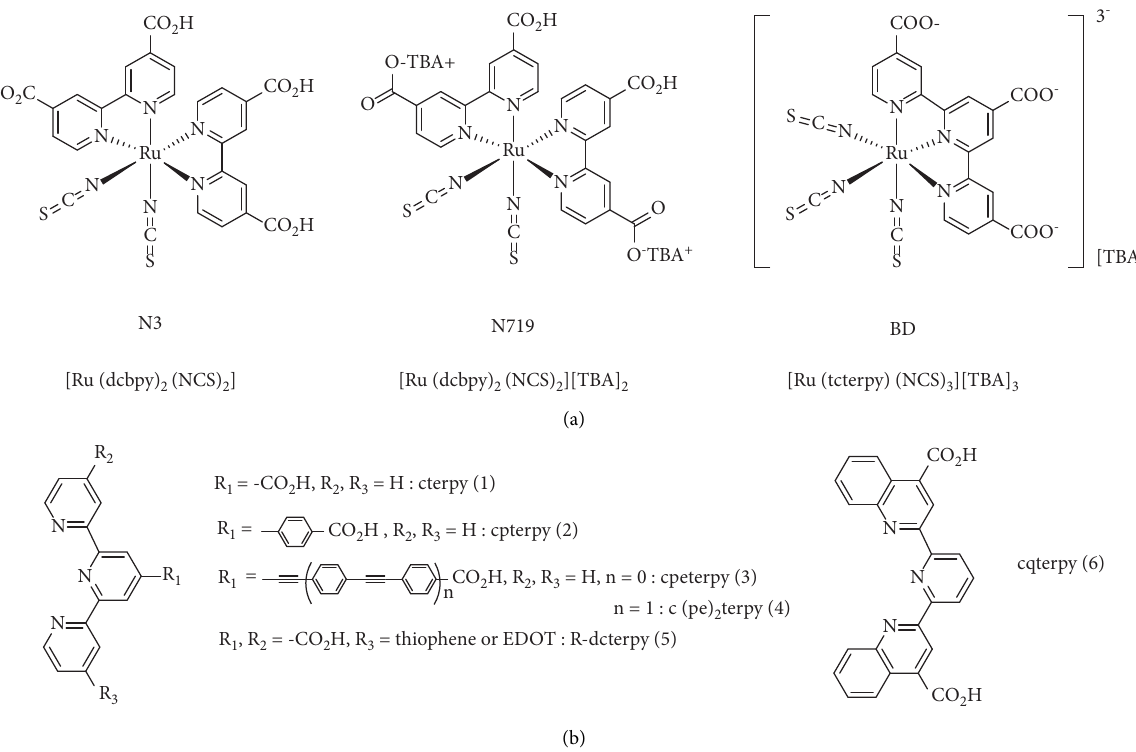
Figure 1: (a) Structures of N3 , N719 , and BD . (b) Terpyridine ligands reported previously in the